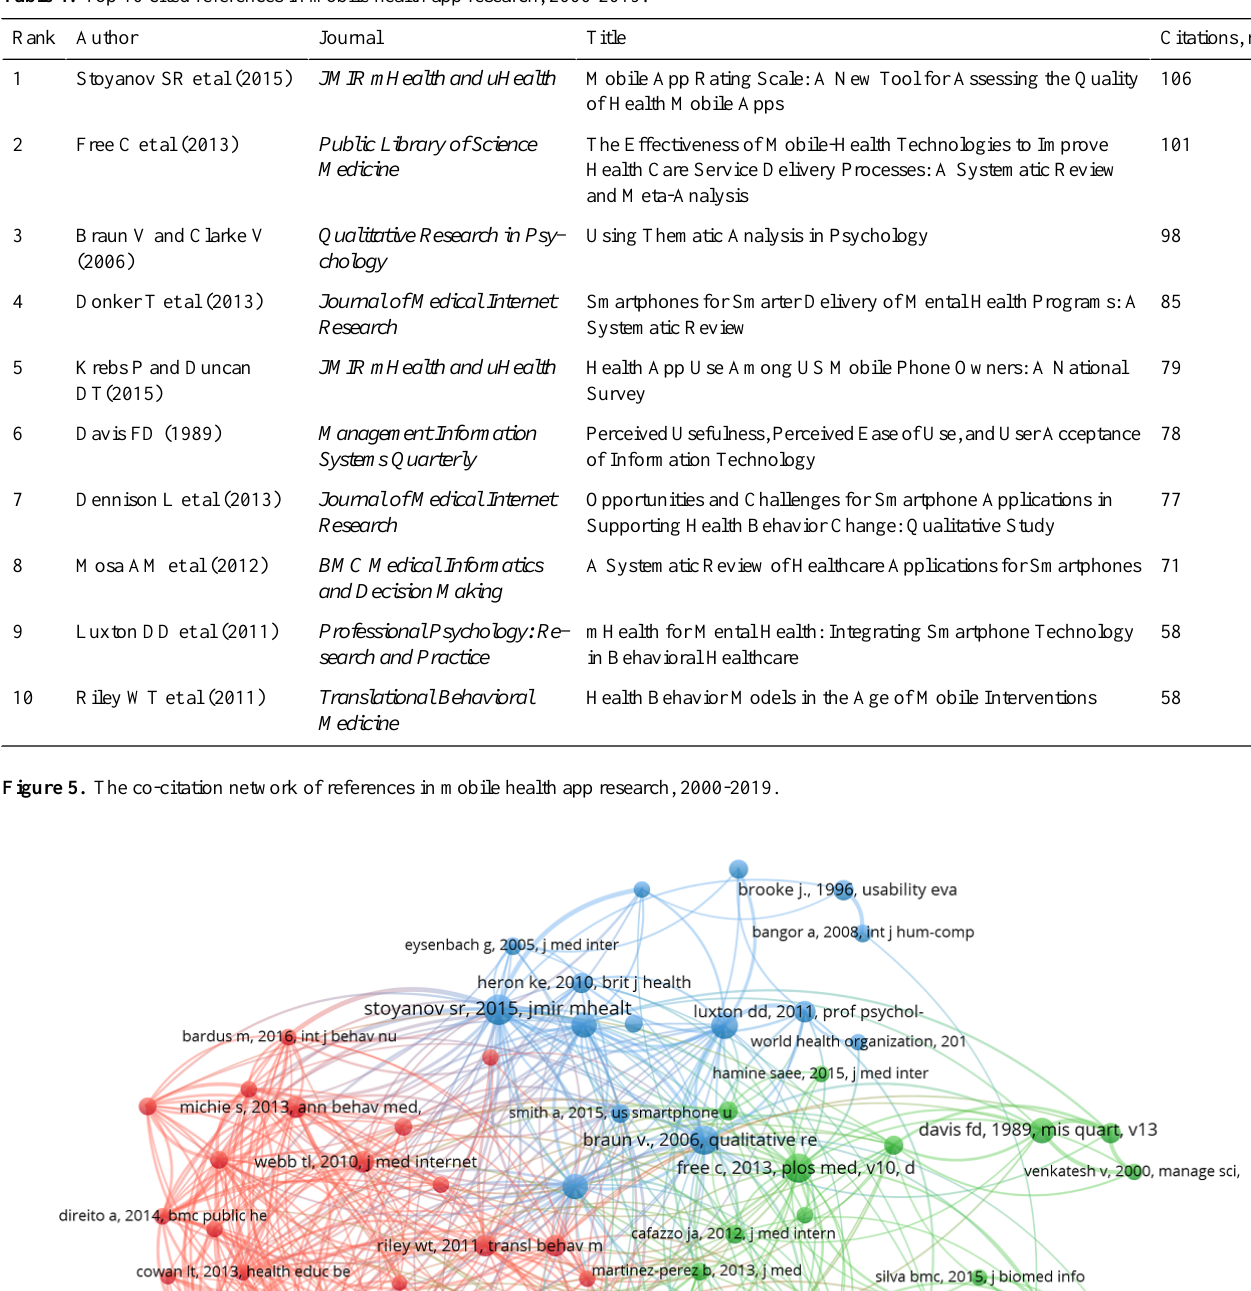
Table 4. Top 10 cited references in mobile health app research, 2000-2019.